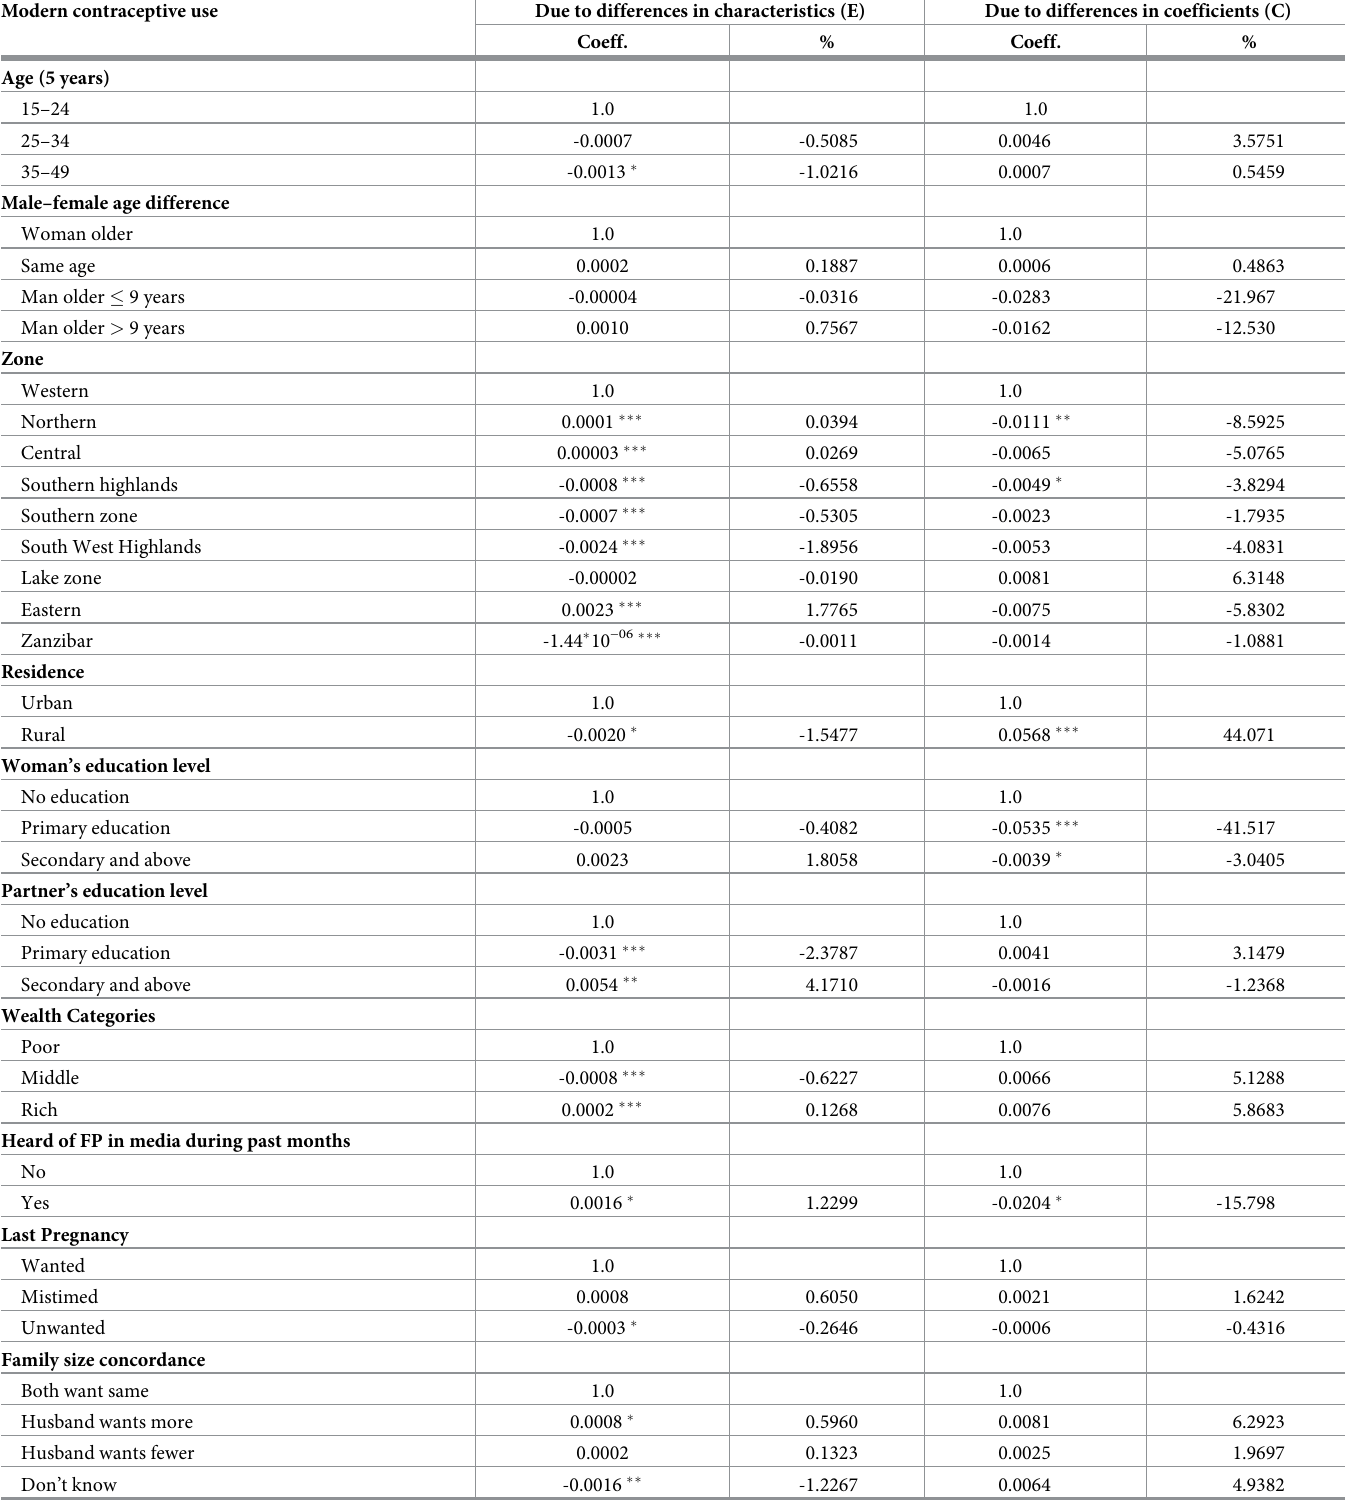
Table 3. Poisson decomposition of changes in modern contraceptive use among women aged 15–49 years in Phase 3 (N =